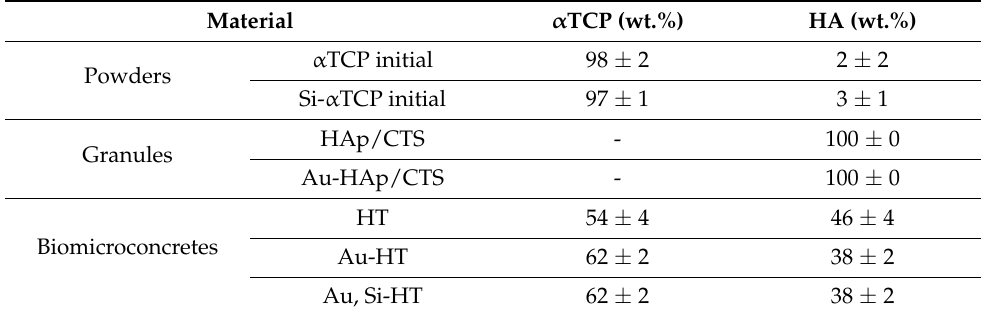
Figure 1. XRD patterns of materials: ( a ) α TCP ( α Tricalcium Phosphate) powder, ( b ) Si- α TCP (silicon-doped α Tricalcium Phosphate) powder, ( c ) hybrid hydroxyapatite/chitosan granules, ( d ) hybrid hydroxyapatite/chitosan granules containing gold nanoparticles, ( e ) material HT, ( f ) material Au-HT, and ( g ) material Au, Si-HT. Table 2. Phase compositions of the initial powders, granules and set